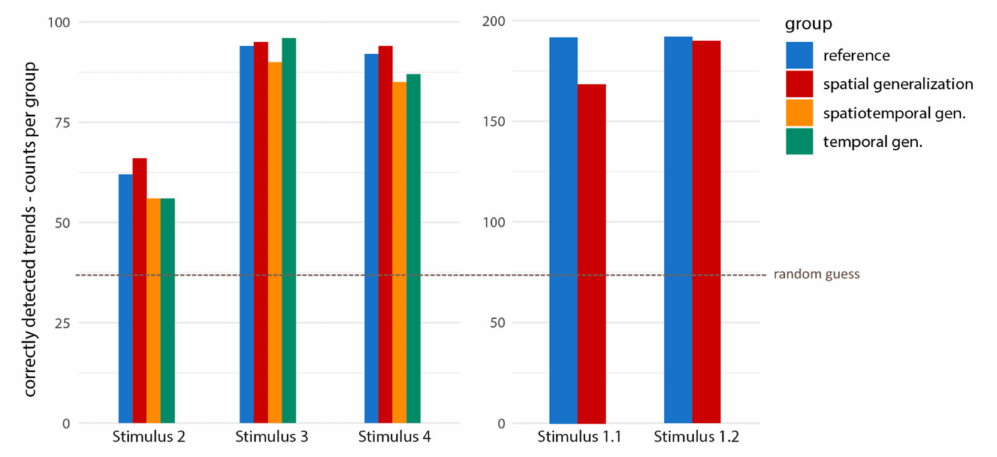
Figure 9. Number of persons per group/generalization type having chosen the correct trend re- sponse